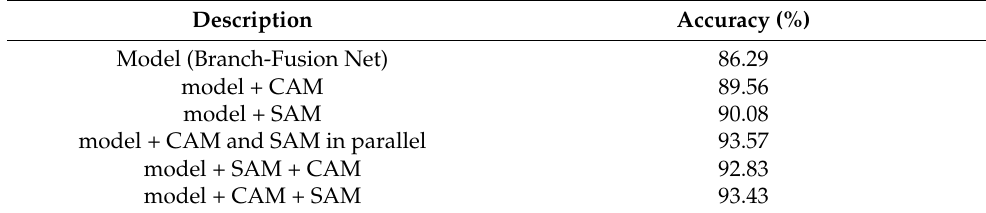
Table 5. Combining methods of channel and spatial attention.